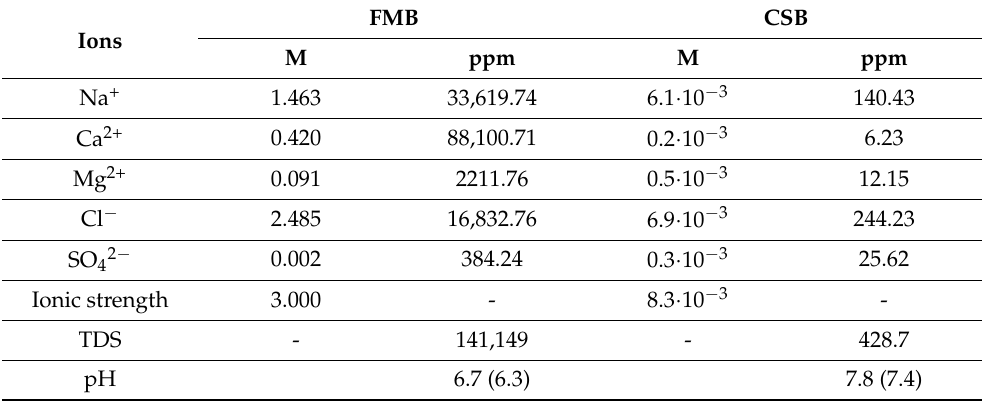
Table 3. Electrolytes and their properties. Concentration of individual ions is given in M (mol/L) and ppm units. Brine concentration expressed as total dissolved solids (TDS) is provided in parts per million (ppm). pH values correspond to 23 ◦ C and (70 ◦